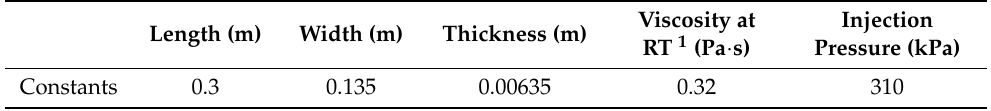
Table 1. Constants used in the determination of specific